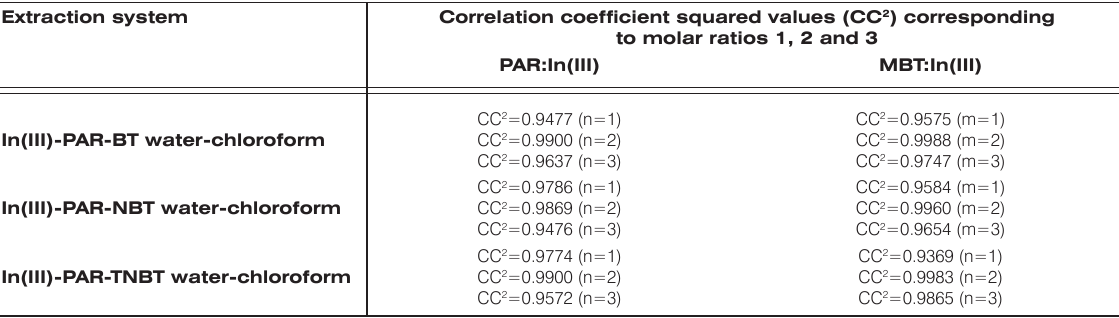
Table 4. Composition and suggested formulae of the ternary In(III)-PAR complexes with participation of monotetrazolium (MT + ) and ditetrazolium (DT 2+ ) cations. Suggested formula Extraction system Tetrazolium Molar ratio cation (In-PAR-T n+ )